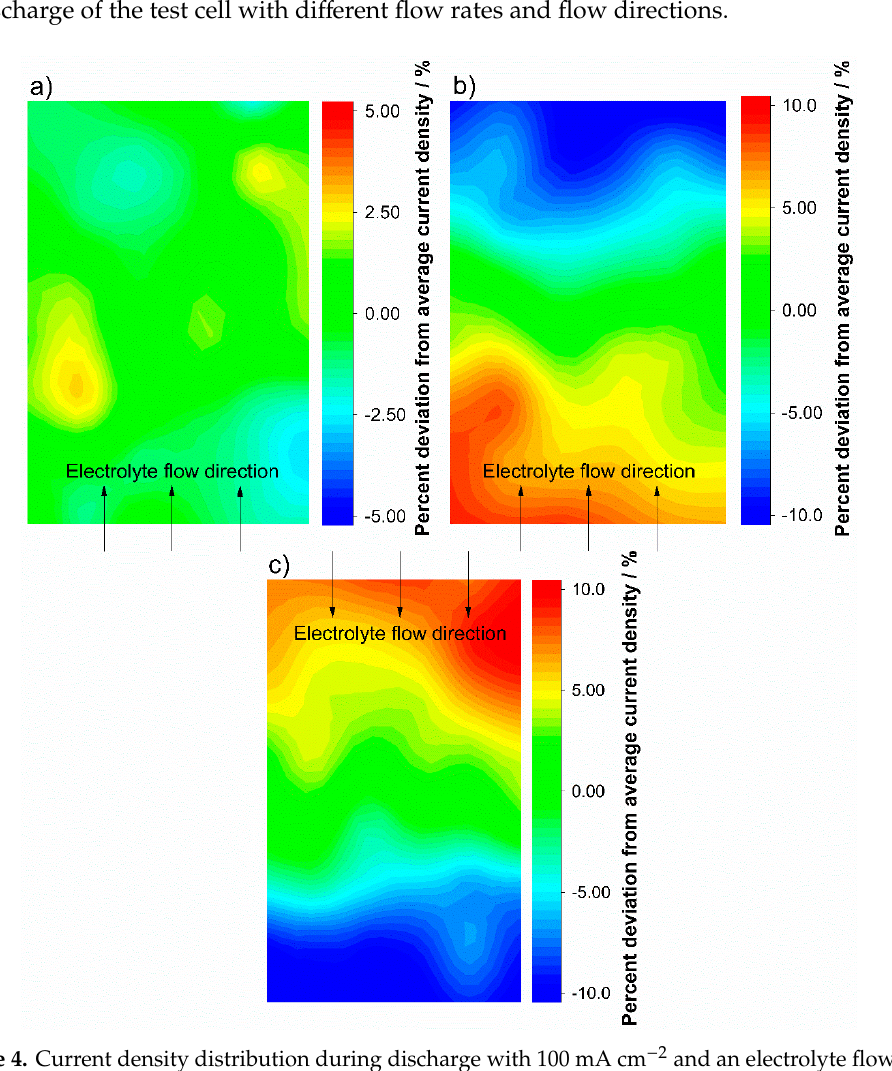
Figure 4. Current density distribution during discharge with 100 mA cm − 2 and an electrolyte flow rate of 2.5 mL min − 1 cm − 2 ( λ ≈ 30) ( a ) and 0.5 mL min − 1 cm − 2 ( λ ≈ 6.5) ( b ) with a bottom inlet configuration. The electrolyte inlet was reversed to a top fed cell at 0.5 mL min − 1 cm − 2 ( λ ≈ 6.5) ( c ). The printed circuit board was installed at the